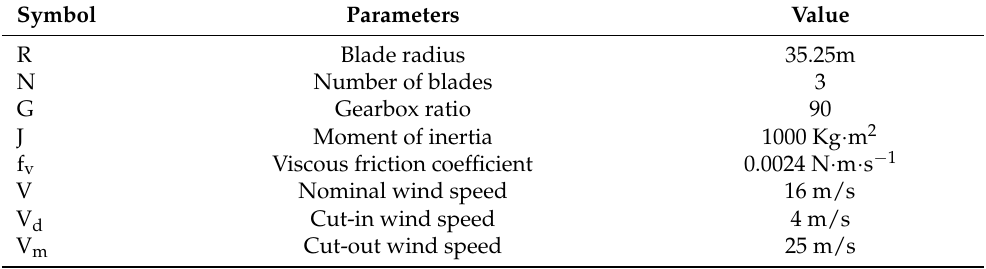
Table A2. Parameters of Turbine.